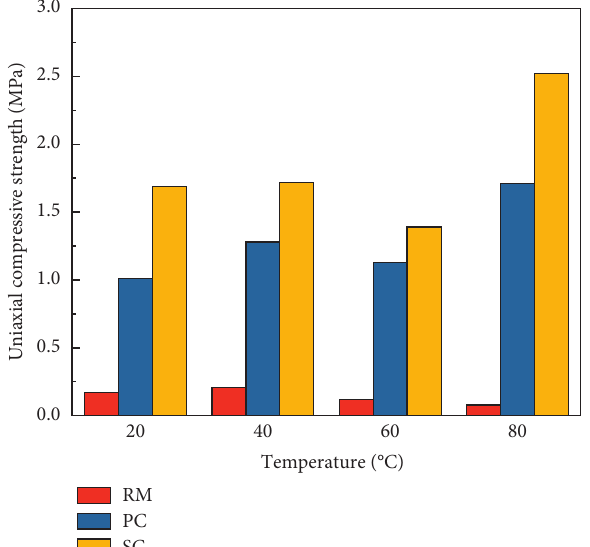
Figure 5: Effect of binder type and temperature on the UCS of CPB after curing for 12 hours.